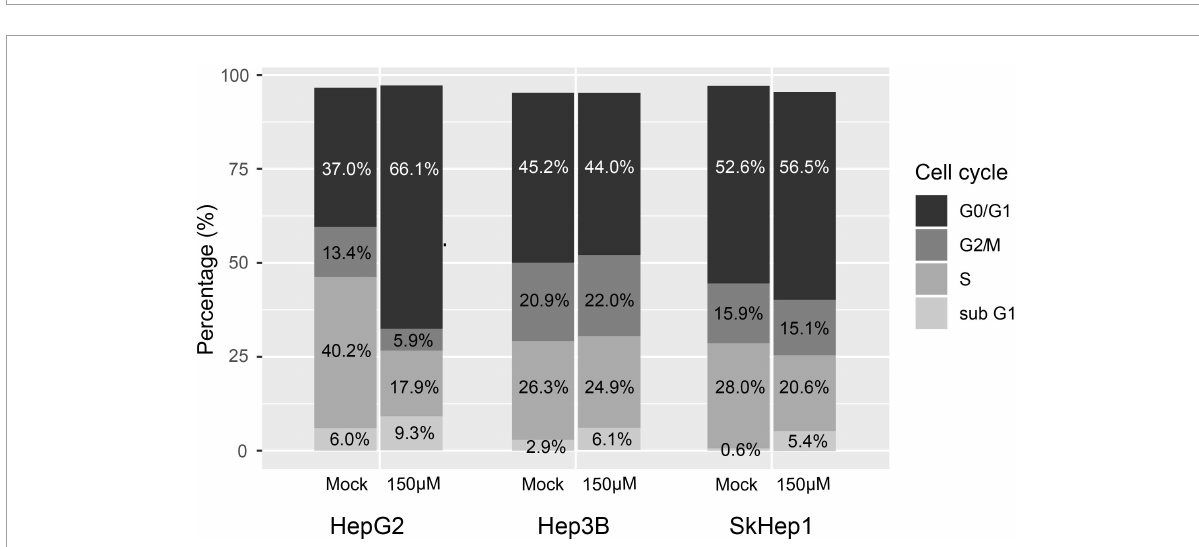
FIGURE5 Treatment response to orlistat assessed using cell cycle analysis with flow cytometry in three HCC cell lines. HepG2 cells in the S/G2/M cell cycle were obviously reduced after orlistat treatment compared with mock treatment, whereas no apparent change was observed in the cell cycle in Hep3B and SkHep1 cells. The proportion was determined by counting 2 × 10 5 cells for each treatment ( n = 2 × 10 5